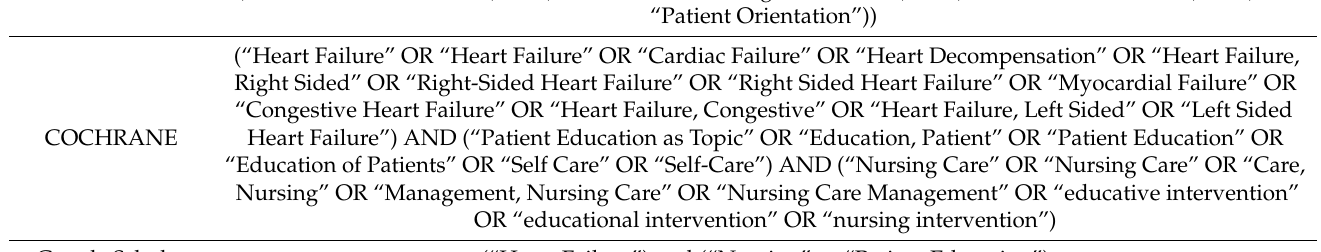
Table A2. Risk of bias assessment.